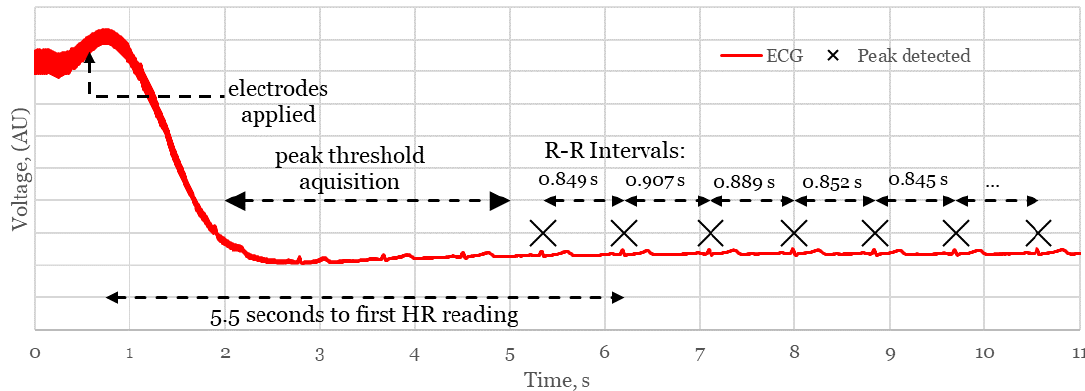
Figure 18. Connection event showing time from sensor application to first HR measurement.